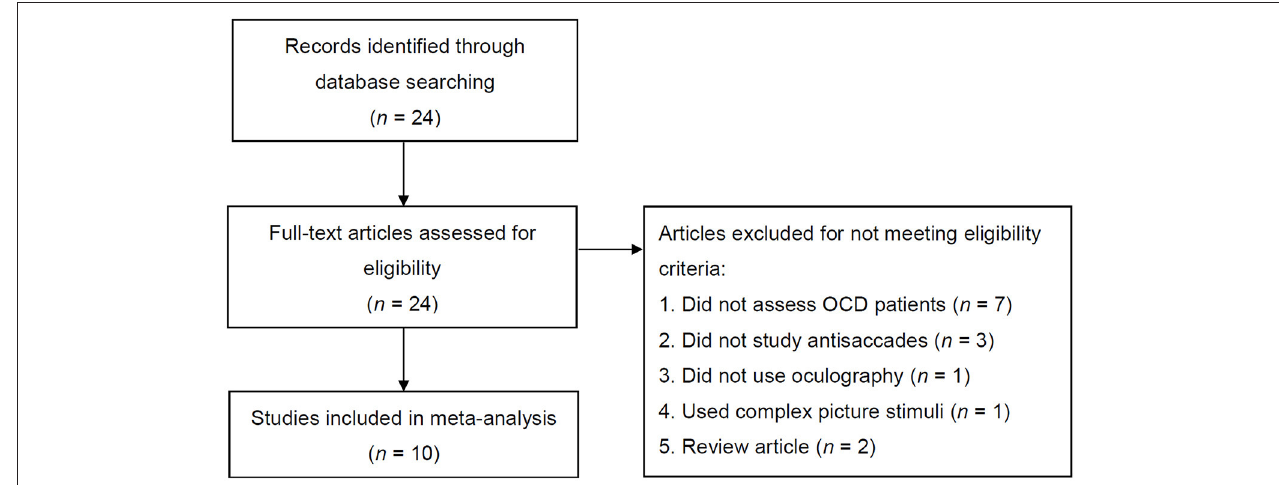
FIGURE 1 | Flowchart showing the process of article selection. OCD, obsessive-compulsive disorder.